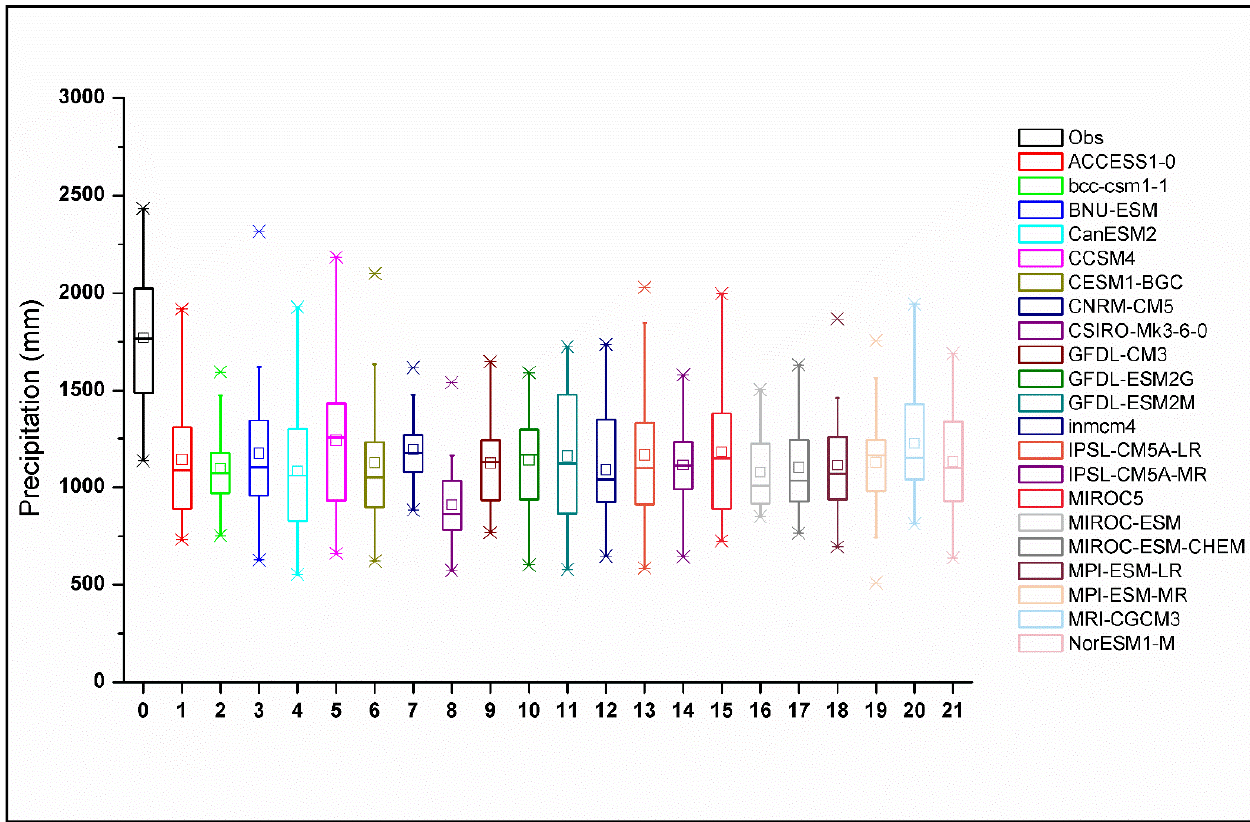
Figure 3. Observed annual precipitation (in black) over Chirah sub catchment for 1980–2004, together with the corresponding estimations provided by the 21 NEX-GDDP models (in colors).